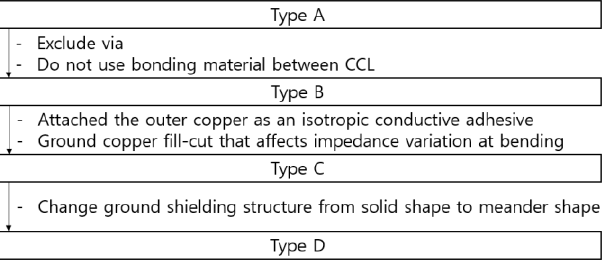
Figure 8. Side view of the rigid-flex structure and cross-section views of the four FPCB structures.